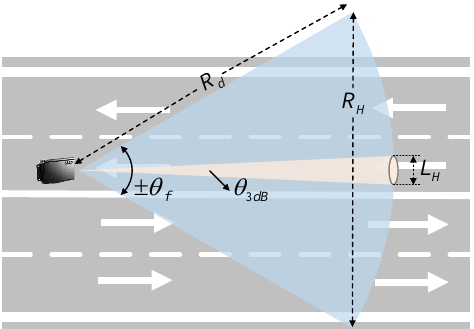
Figure 3. The schematic for automotive radar sensing.